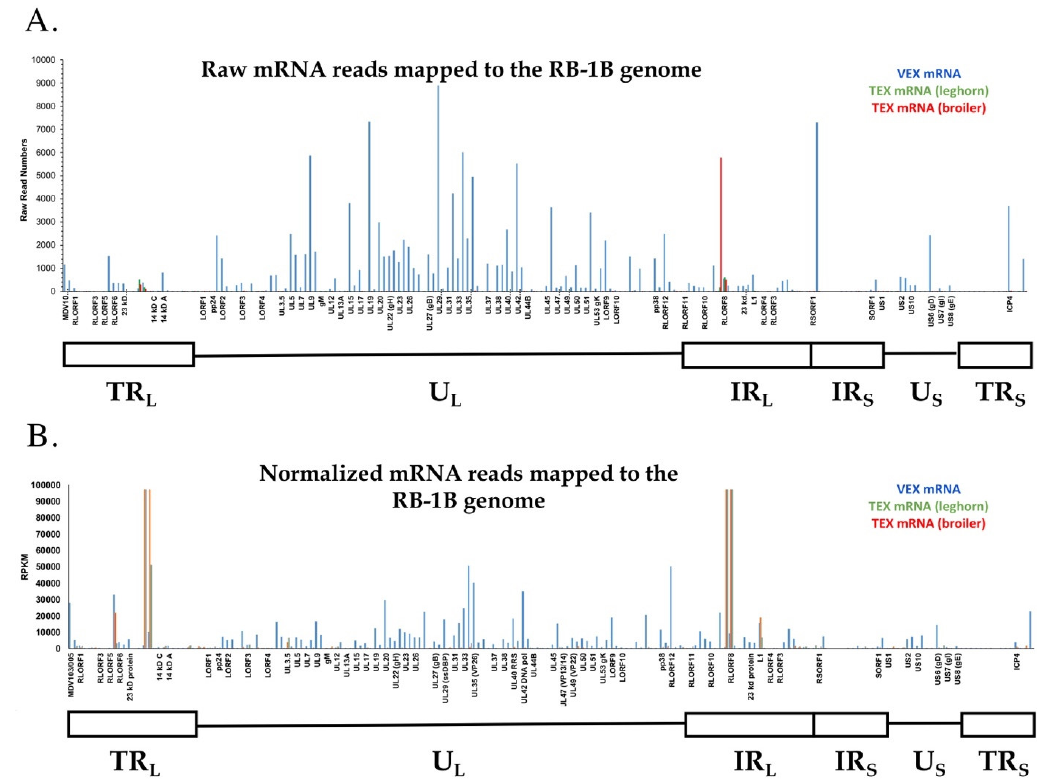
Figure 6. Exosomal mRNAs mapping the MDV genome. Panel ( A ) shows the raw read number of exosomal mRNAs mapping to the MDV genome from leghorn VEX (blue), leghorn TEX (green) and broiler TEX (red). Panel ( B ) shows these data normalized to gene size and read abundance (RPKM).